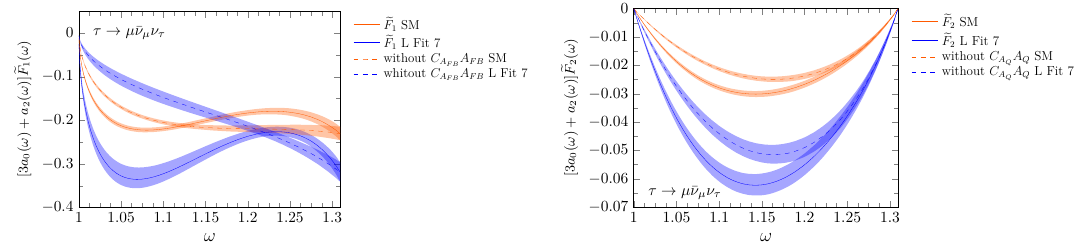
( ω ) with those 1 , 2